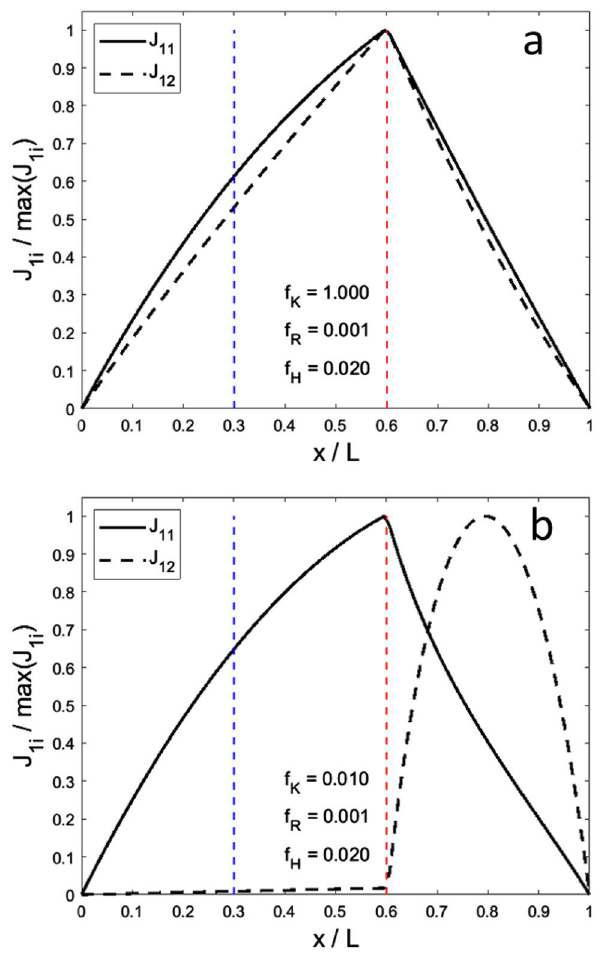
Fig. 3 First component of sensitivity matrix or Jacobian ( 𝐉 , defined in Eq. 3) as function of the position of the observation well. a Homogeneous and b heterogeneous aquifer. Dashed red line shows position of interface between materials x K and blue line shows position of well with measured head x